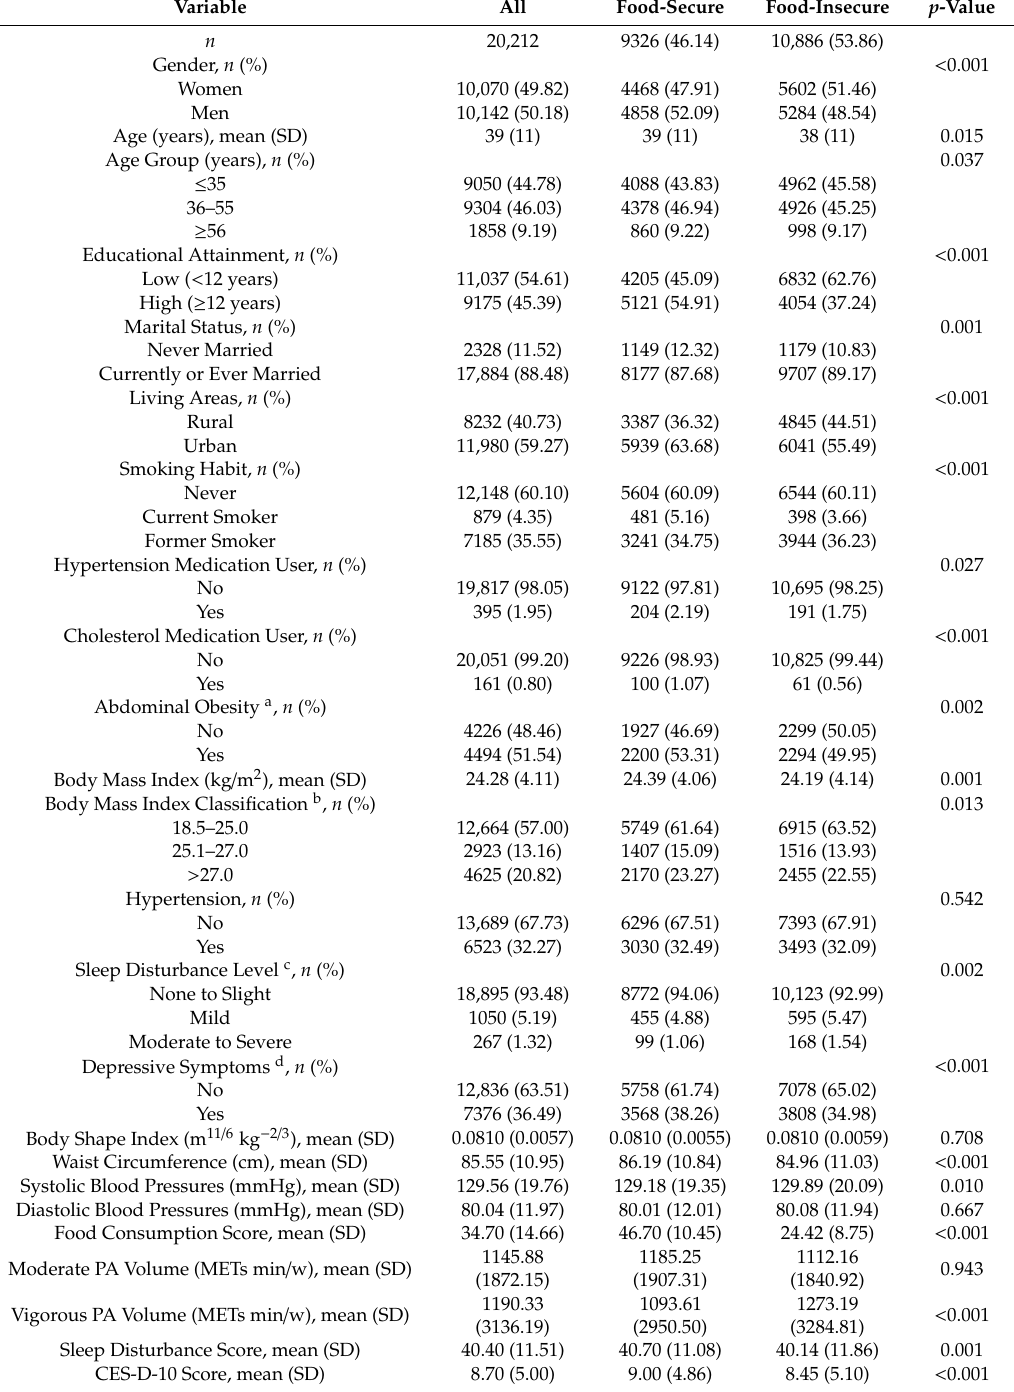
Table 1. The participants’